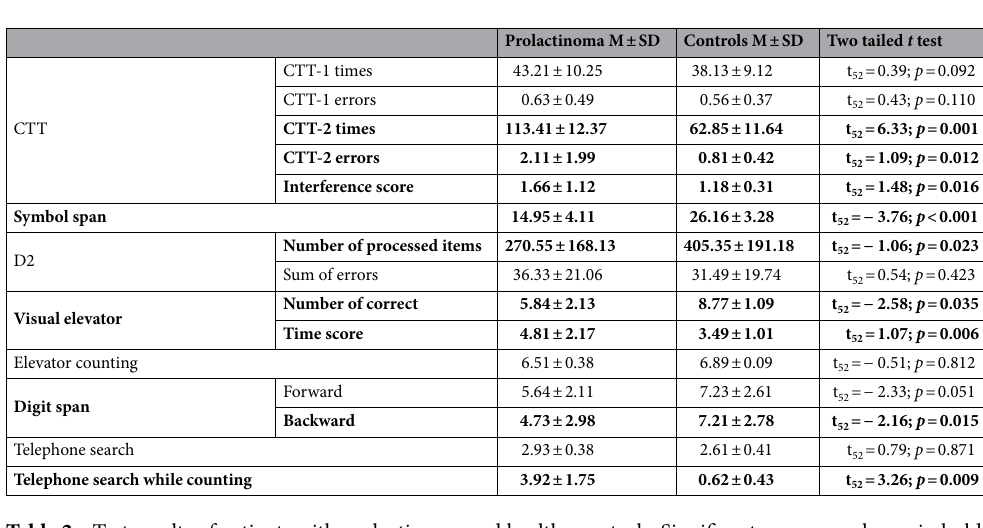
Table 2. Test results of patients with prolactinoma and healthy controls. Significant scores are shown in bold. M mean, SD standard deviation, s seconds, CTT color trails test, D2 D2 test of